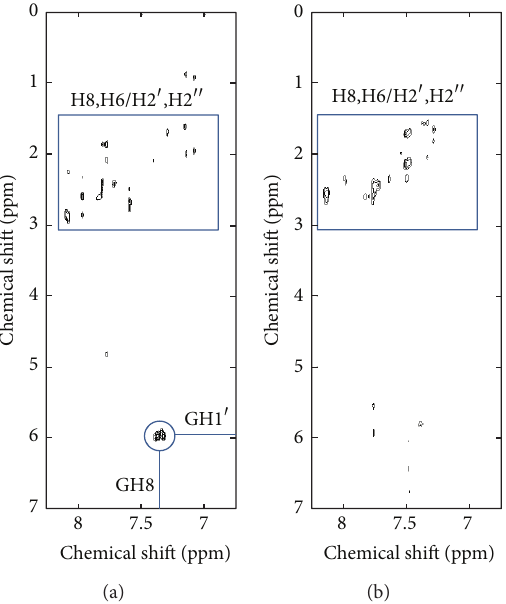
Figure 4: The 2D NOESY NMR spectra for TFBS (a) and 4A018 (b) in D 2 O acquired with a 0.2s mixing time.